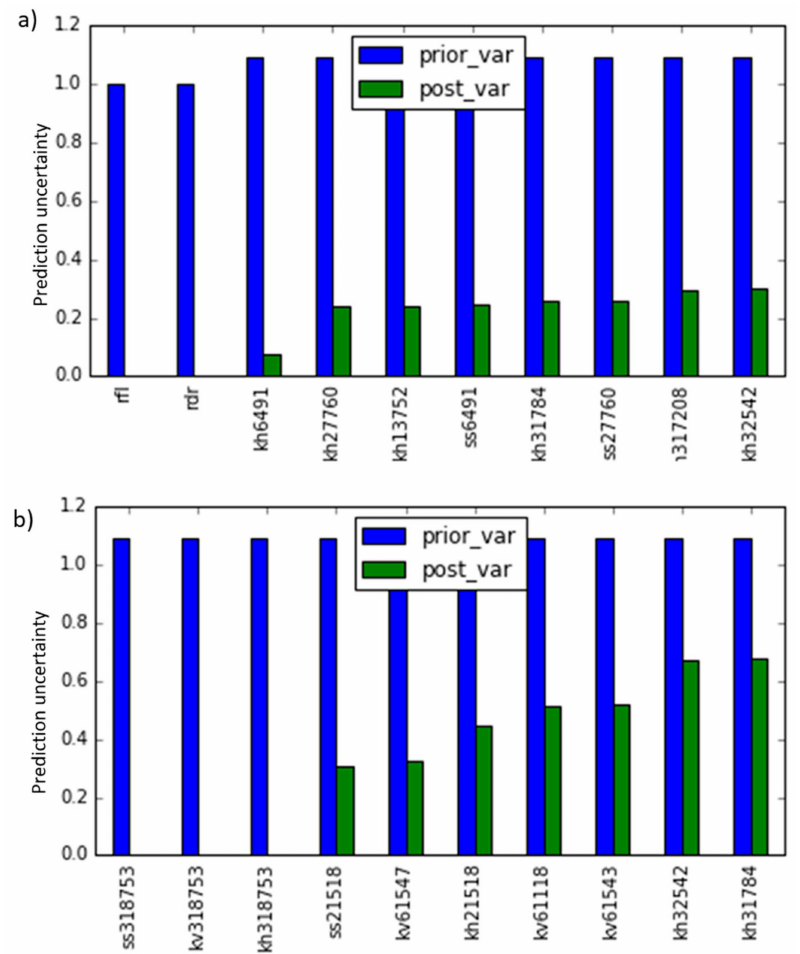
Figure 13. Top 10 parameters for which uncertainty reduction is achieved by using ( a ) existing monitoring network and ( b ) proposed monitoring bores in deeper